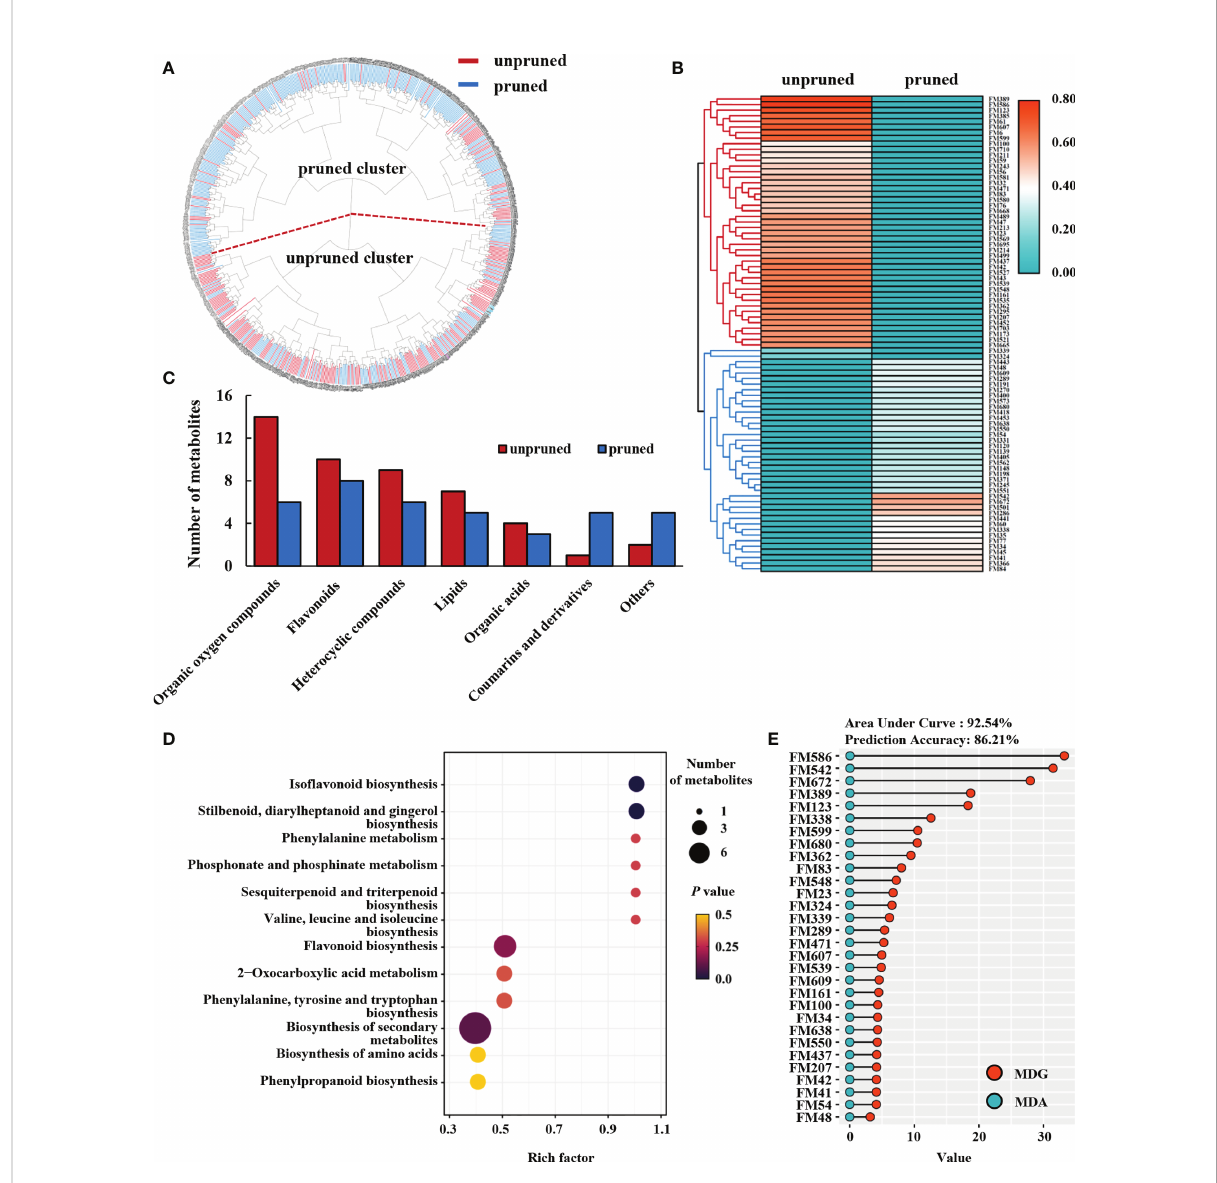
FIGURE 2 Metabolomic analysis of fresh tea leaves from pruned plants. (A) Cluster analysis of tea leaf samples. (B) Heatmap analysis of differential metabolites. Heat map values are normalized for the relative content of differential metabolites, and the average is calculated for each of the two pruning types of tea plant. (C) Class analysis of differential metabolites. (D) KEGG enrichment analyses of differential metabolites. (E) Random forest analysis of characteristic differential metabolites in fresh tea leaves. MDG, mean decrease Gini, MDA, mean decrease